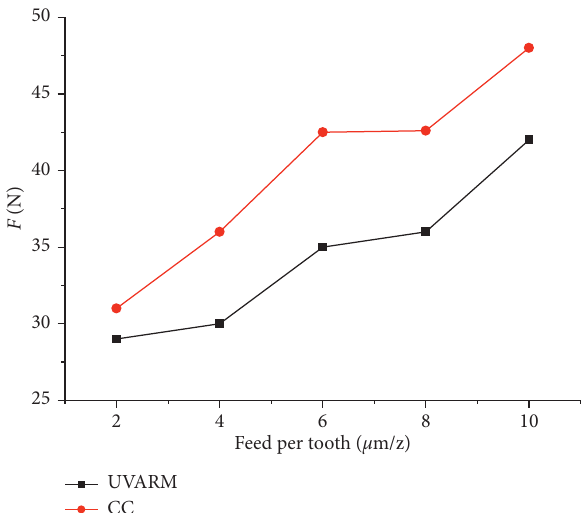
Figure 13: Fx changes with feed per tooth.